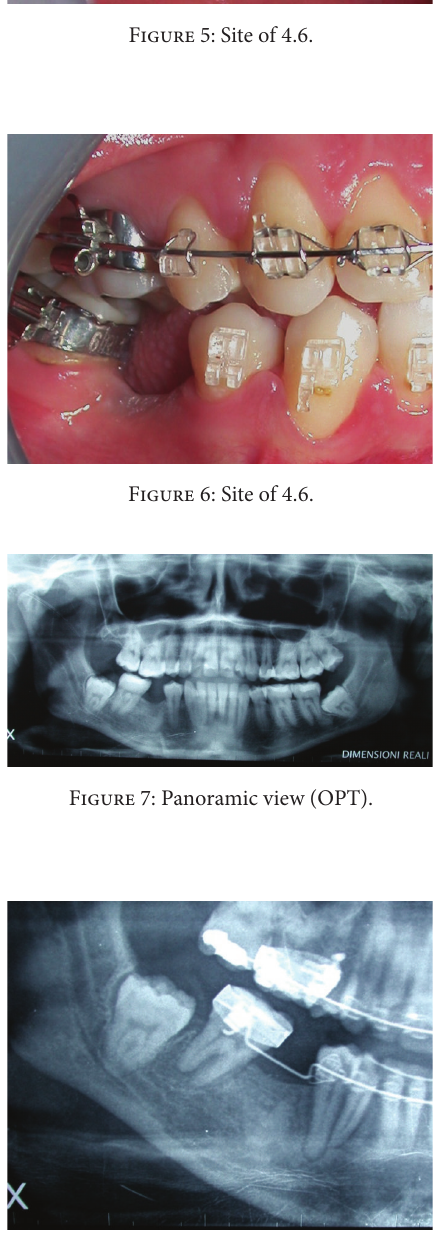
Figure 8: Radiographic view of